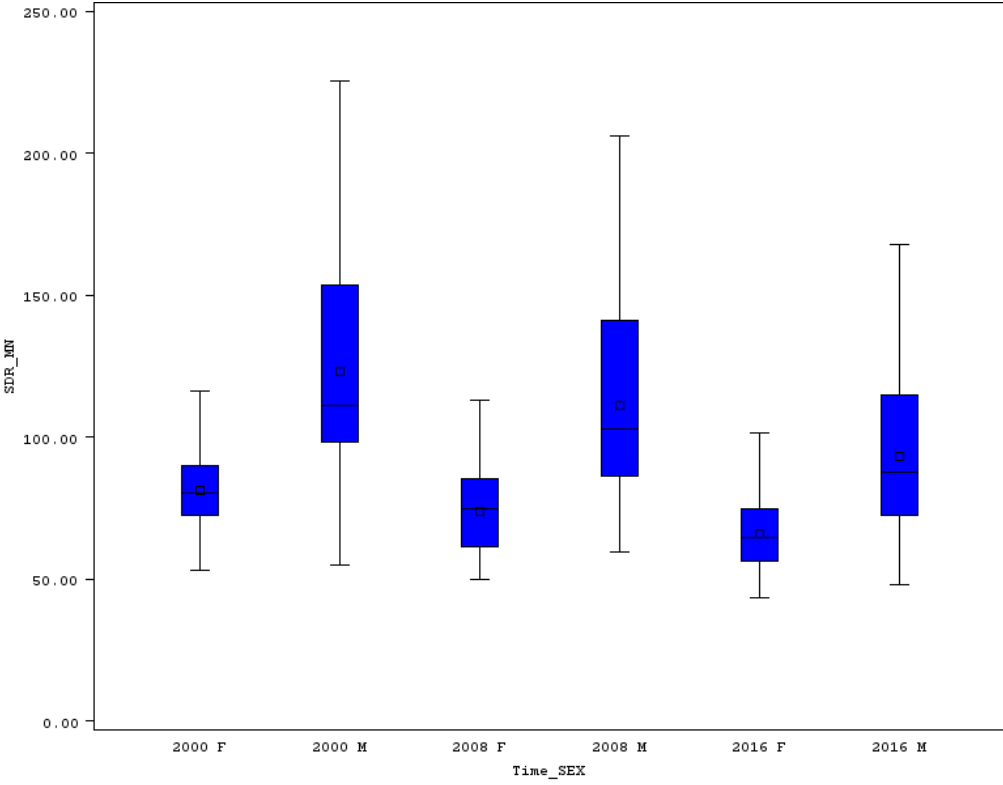
Figure 3. Boxplot of premature SDR for malignant neoplasms in EU countries for males and females in selected years. Source: Own calculations based on Eurostat database [20].